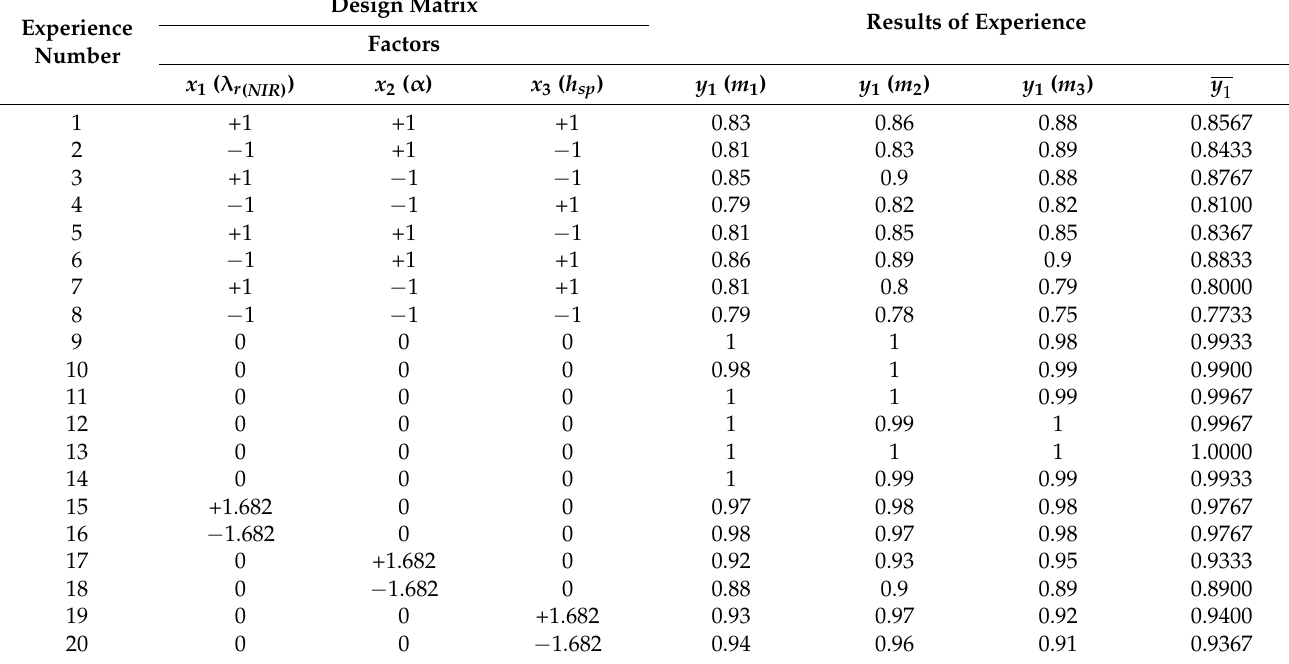
Table 4. Planning matrix for testing the efficiency of grading Scots pine seeds using a grader in the NIR wavelength